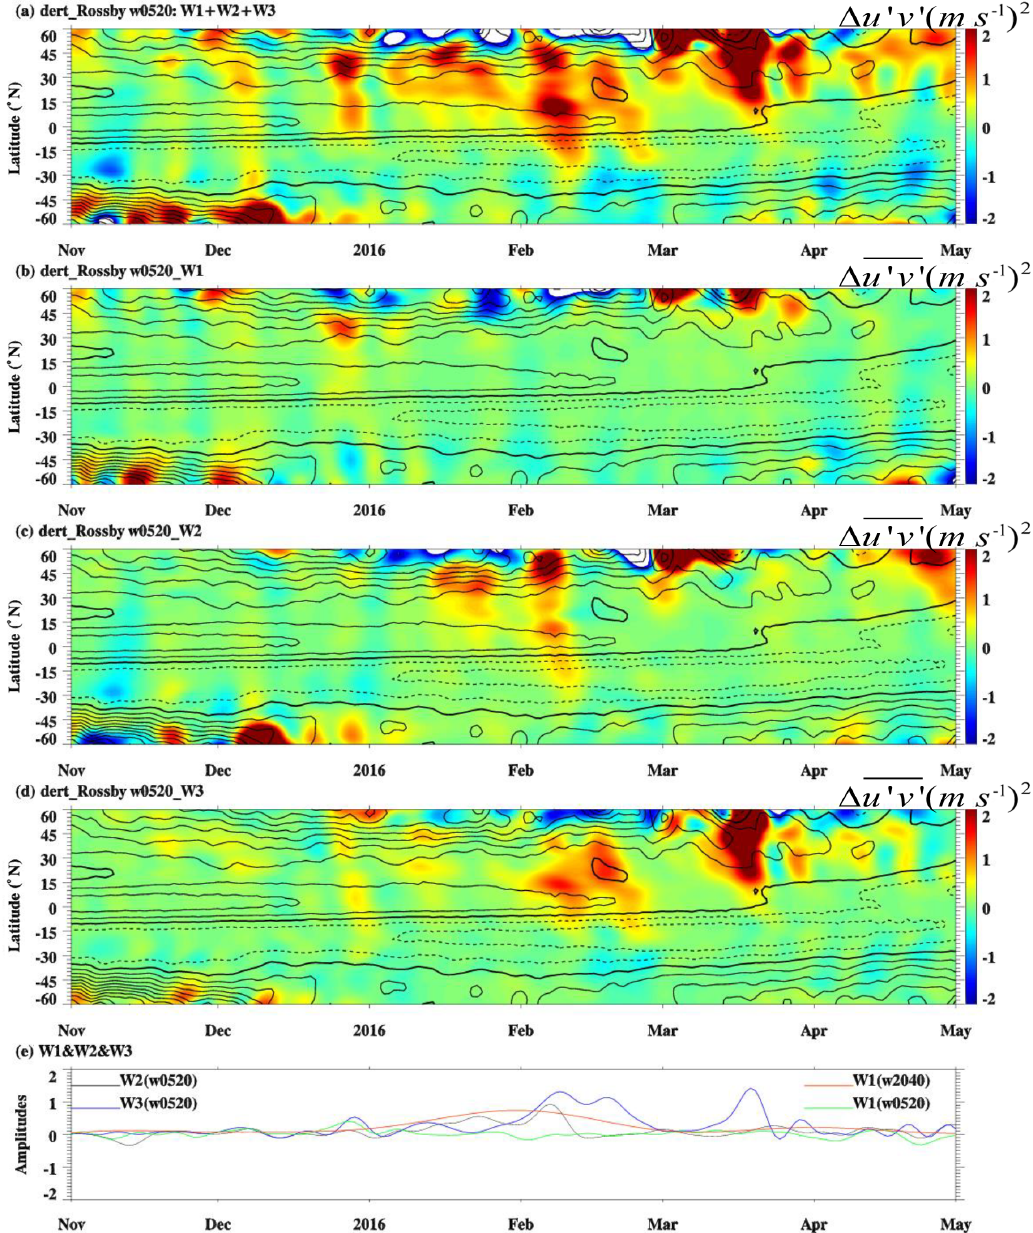
Figure 10. The time–latitude cross section of Rossby w0520 horizontal momentum flux anomalies (a) W1 + W2 + W3, (b) W1, (c) W2, and (d) W3 from November 2015 to April 2016. Color shadings denote the anomalies with respect to the monthly climatology (0m 2 s − 2 ). The zonal mean zonal wind is overlaid in black contours with contour interval of 5ms − 1 . The solid and dotted black contours denote westerly and easterly winds, respectively. The thick contours represent the zero wind line. W1, W2, and W3 denote the Rossby w0520 with wavenumber 1, 2, and 3, respectively. Panel (e) shows the horizontal momentum flux anomaly of W1, W2, W3, and Rossby w2040 (with wavenumber 1) at 40hPa averaged from 10 to 20 ◦